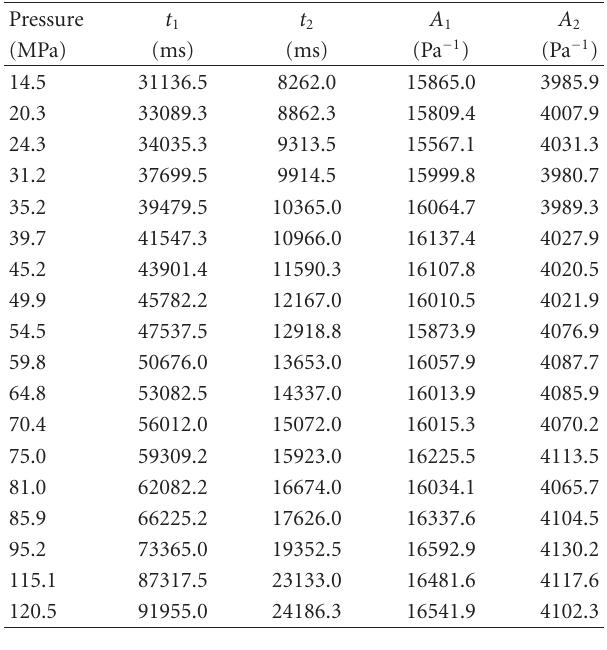
Table 3: Summary of experimental data for sinkers 1 and 2.